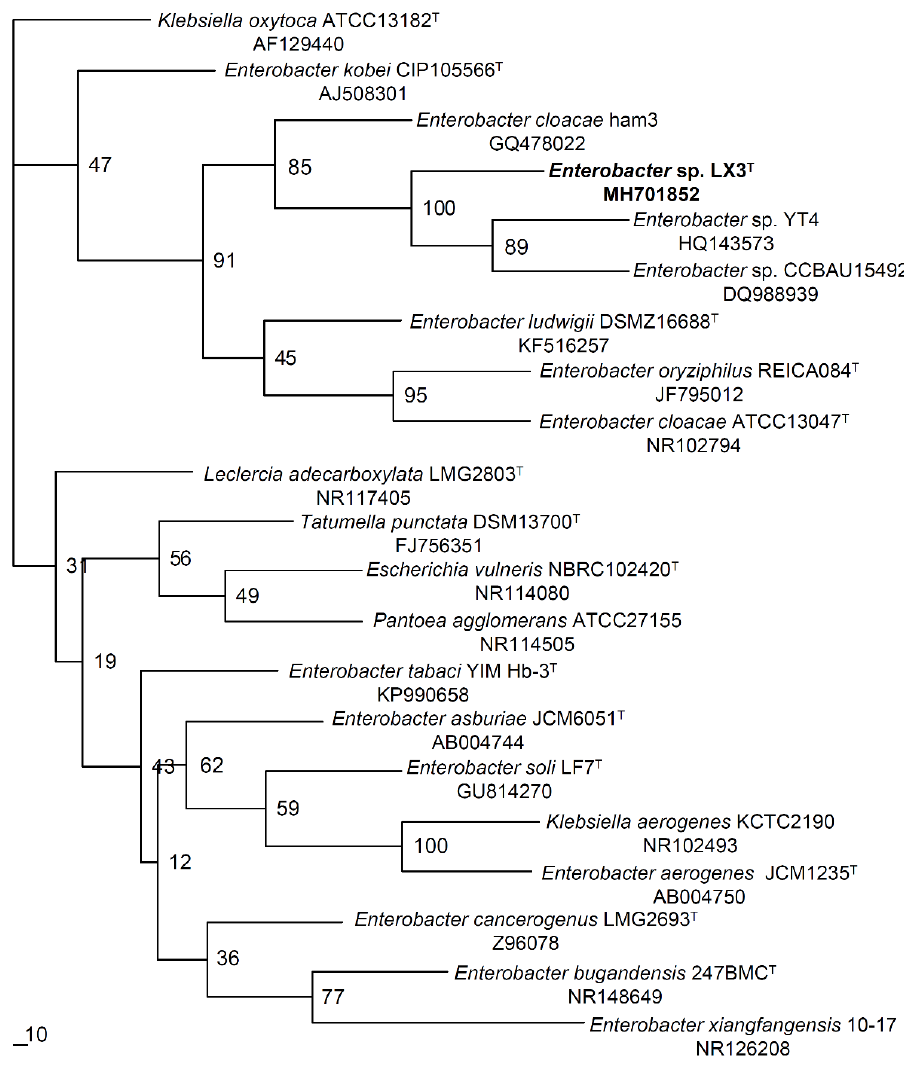
Figure 2. Phylogenetic tree constructed based on 16S rRNA gene sequence comparisons between isolate LX3 and some close relatives. A percentage of 100 replications showed on branching points represented bootstrap value. Bar length indicates 1% sequence divergence.